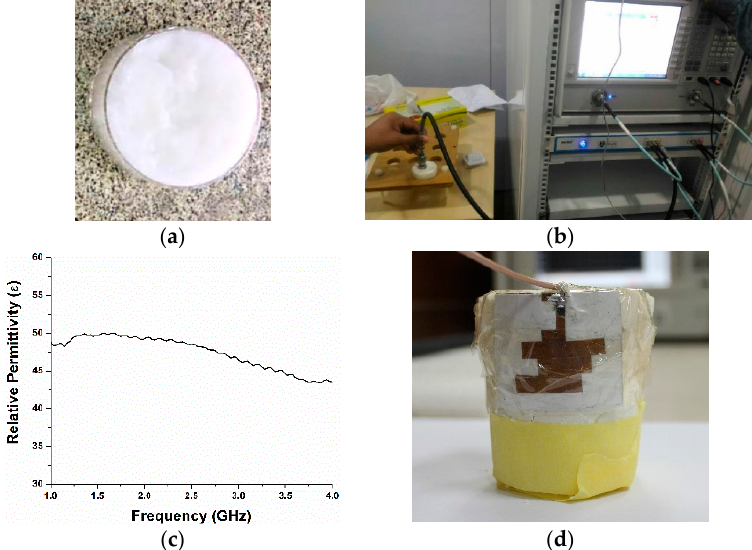
Figure 6. ( a ) Sample material; ( b ) sample material during measurement; ( c ) dielectric property of the muscle phantom; ( d ) antenna mounted with the muscle phantom.